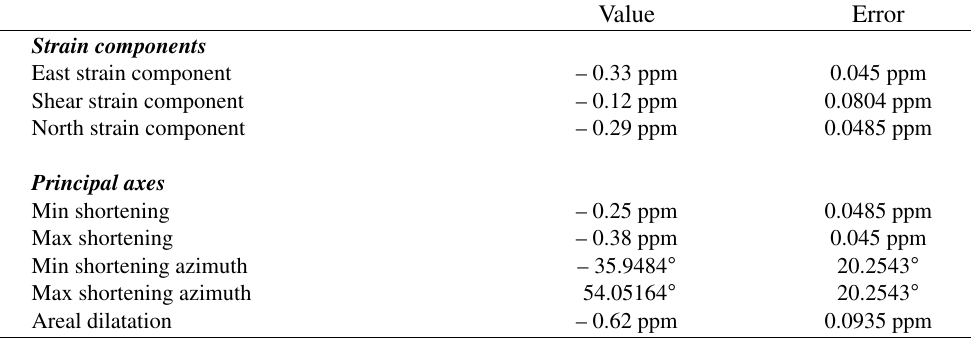
Table VIII. Overall strain field computed for the geodetic network. The areal dilatation is the sum of the north and east components. Negative values represent shortening. The network displays a general contraction with a maximum shortening axis trending